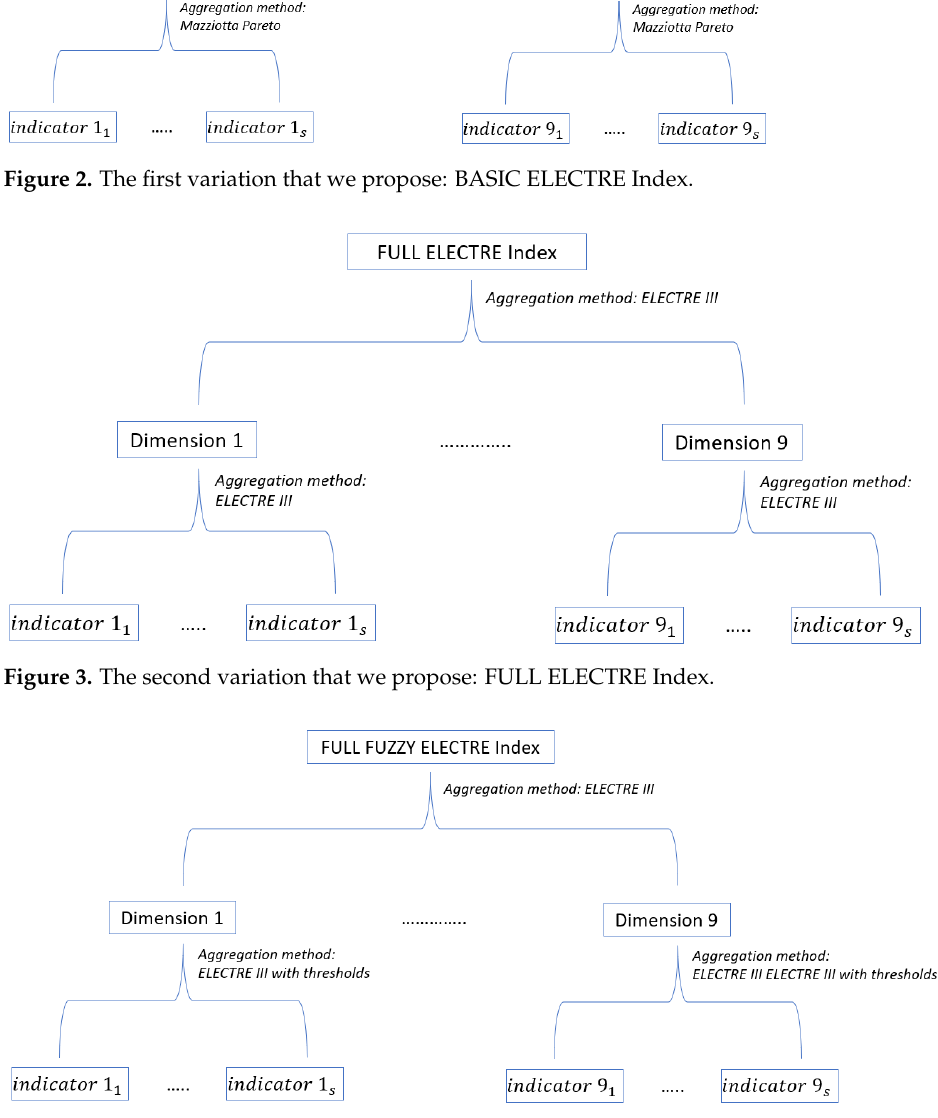
Figure 4. The third variation that we propose: FULL FUZZY ELECTRE Index.